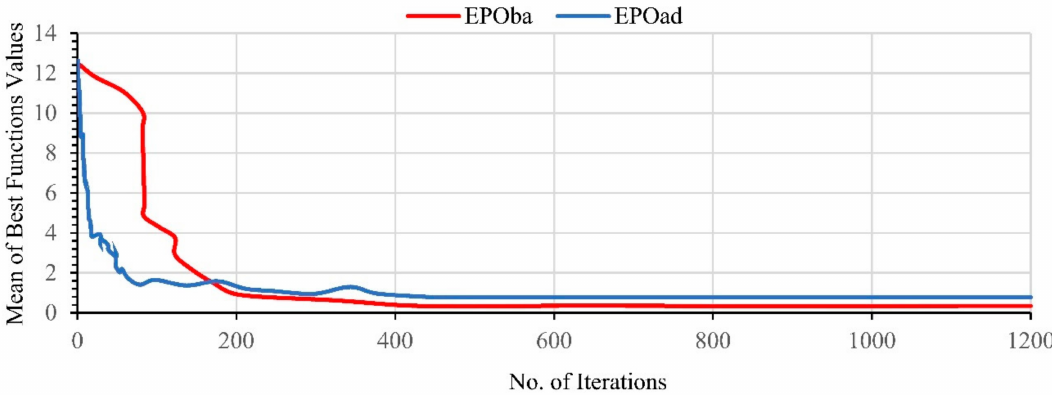
Figure 4. Convergence curve of SOP extraction using EPO algorithms.